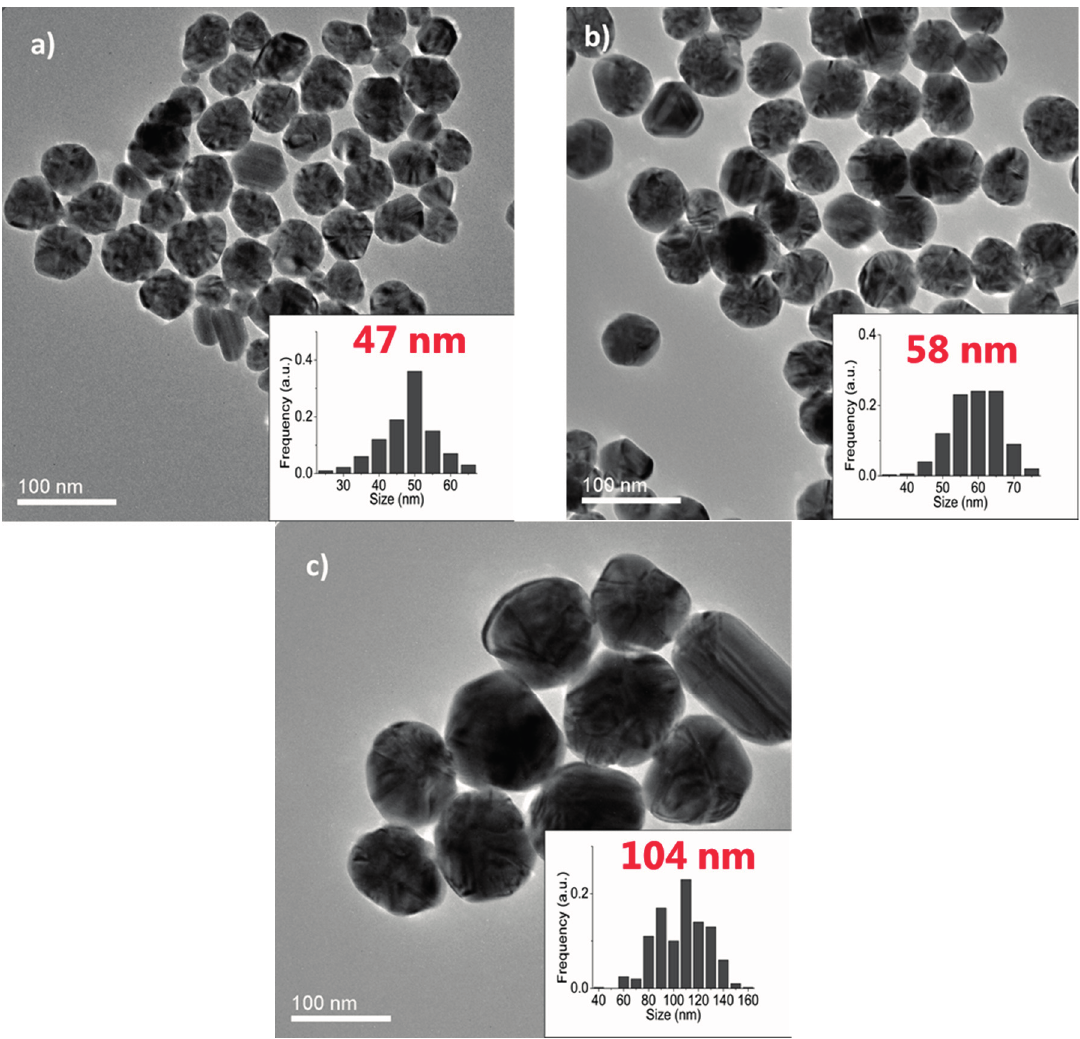
Figure 5. TEM micrographs of AgNPs obtained from the polyol synthesis performed in the SFTR. The average, TEM, particle sizes are: ( a ) 47 nm; ( b ) 58 nm and ( c ) 104 nm. Reprinted from [28] with